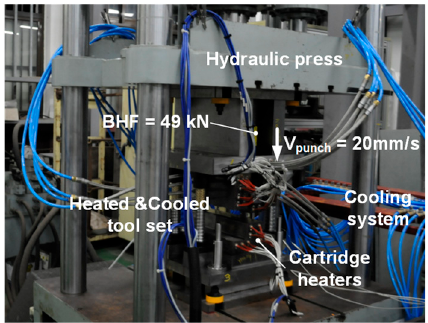
Figure 9. Experimental set-up for tailored tool thermomechanical treatment of hat-shaped part. Table 6. Comparison of predicted hardness between FE simulation and process